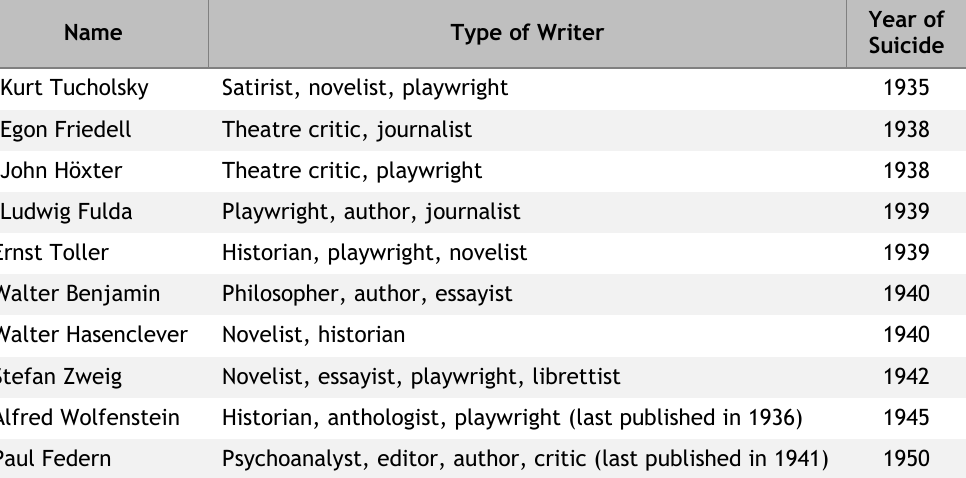
Table 1. Selected List of Jewish Writers Who Committed Suicide in the Pre-war/War Period.